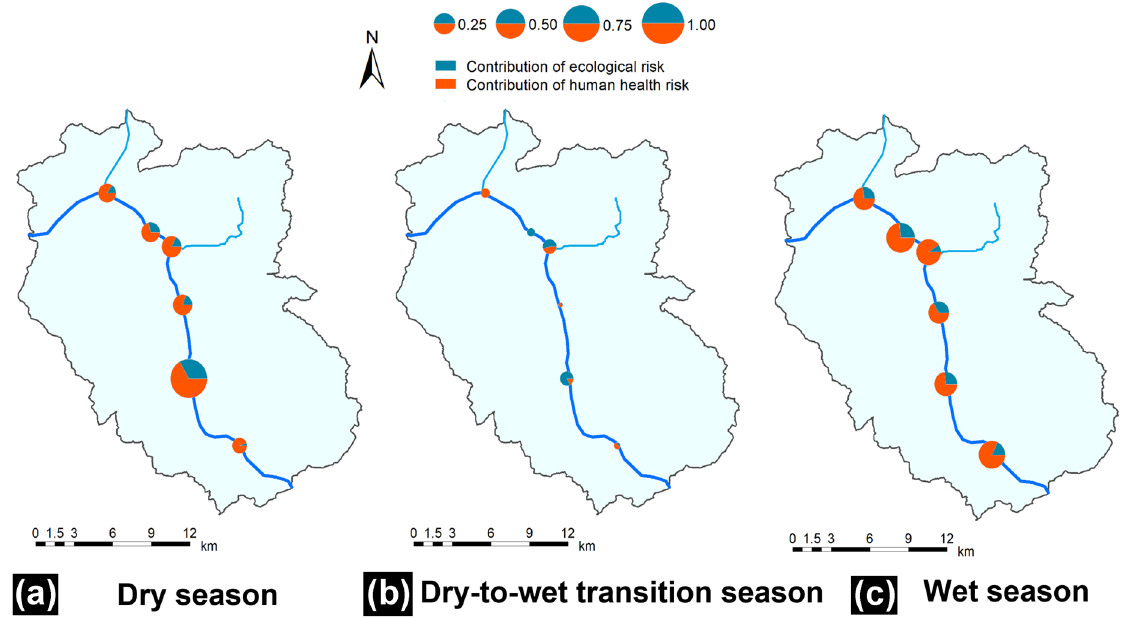
Figure 4. Regional environmental risk assessment results in multiple compartments in the study area. ( a ) dry season, ( b ) dry-to-wet transition season, and ( c ) wet season. This figure was generated using the ArcGIS Desktop (ESRI, Inc, Version 10.7, URL:https:// deskt op. arcgis. com/ zh-